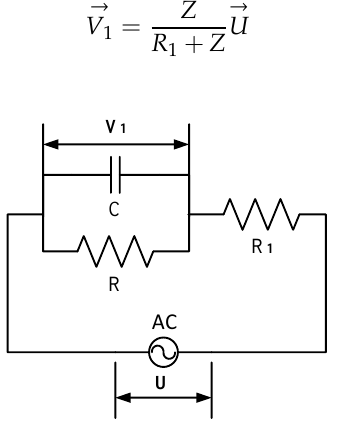
Figure 7. Experimental circuit.